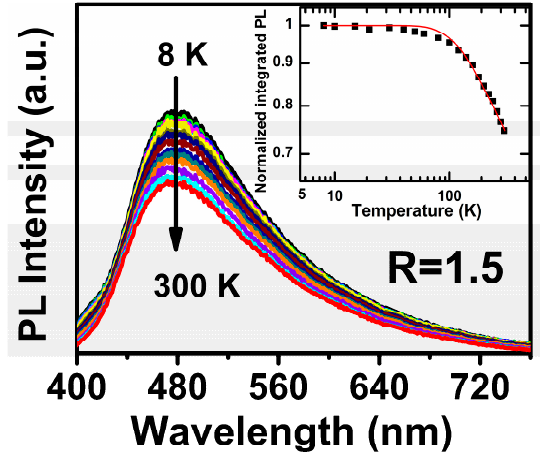
Figure 3. TD-SSPL spectra of a-SiN x O y samples with R = 1.5. The inset exhibits normalized integrated PL intensities and the related simulations vs. measurement temperatures.